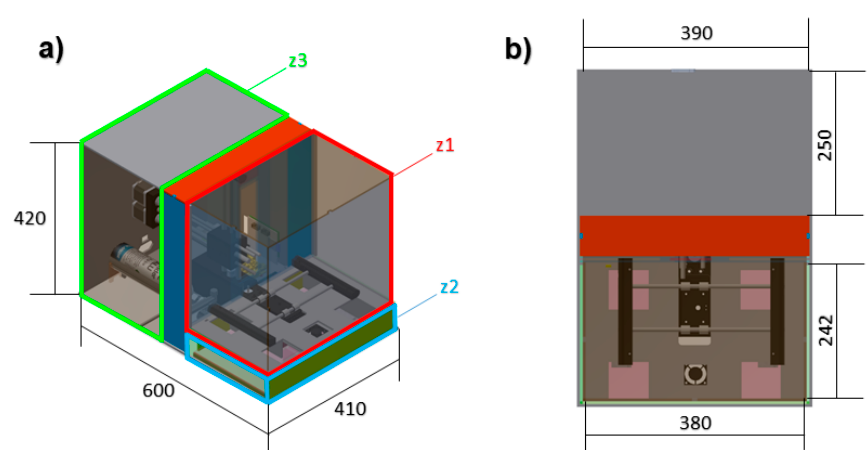
Figure 1. Atmospheric enclosure top ( a ) and lateral ( b ) view.